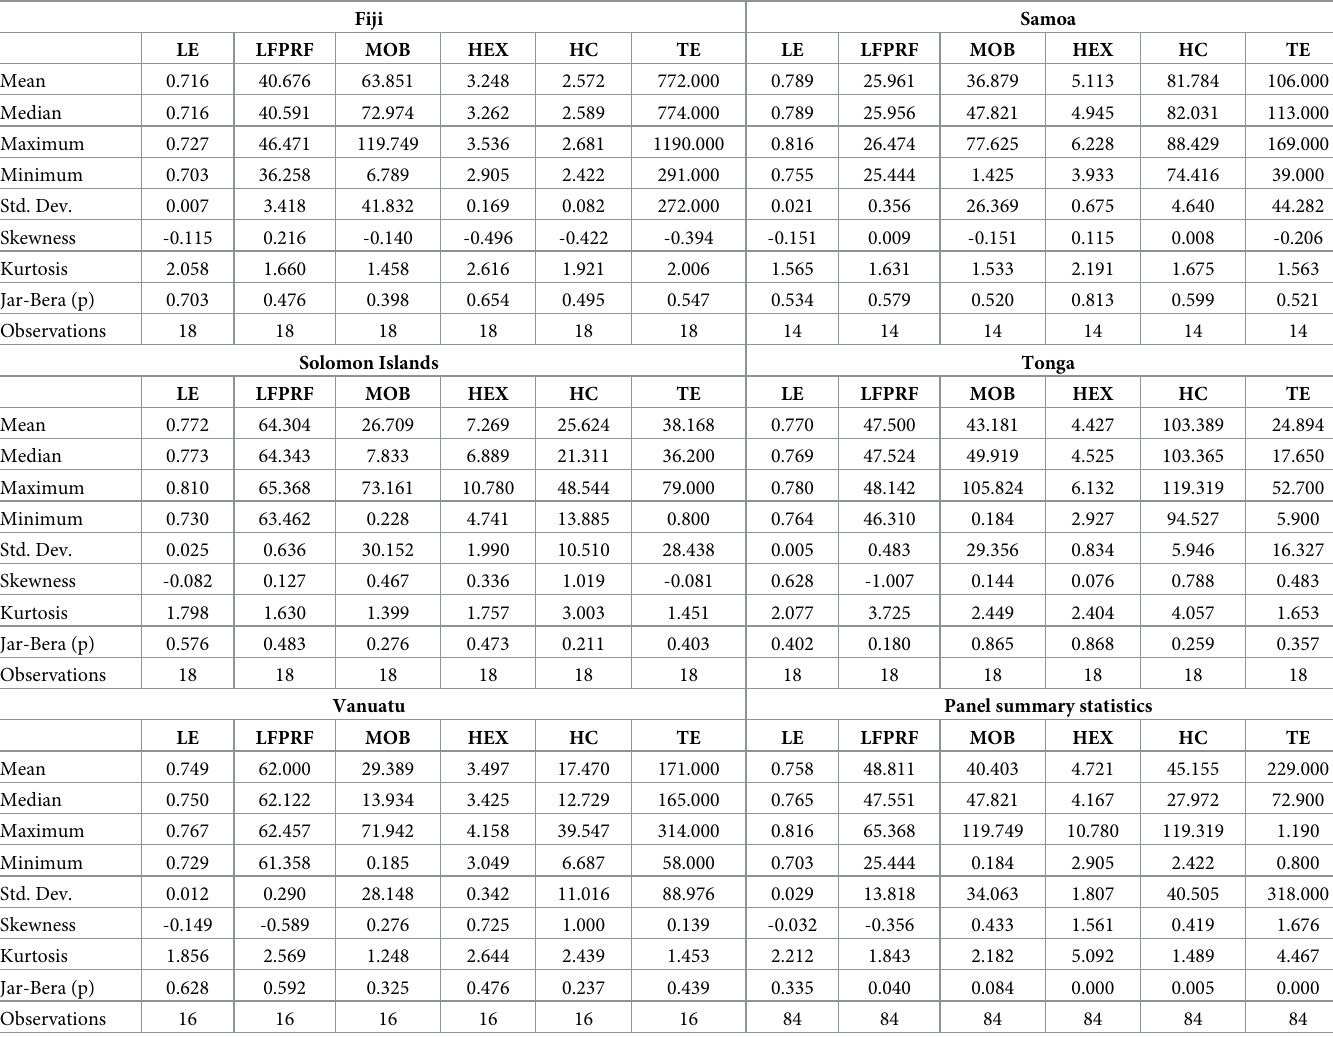
Table 1. Summary statistics for Pacific Island countries.